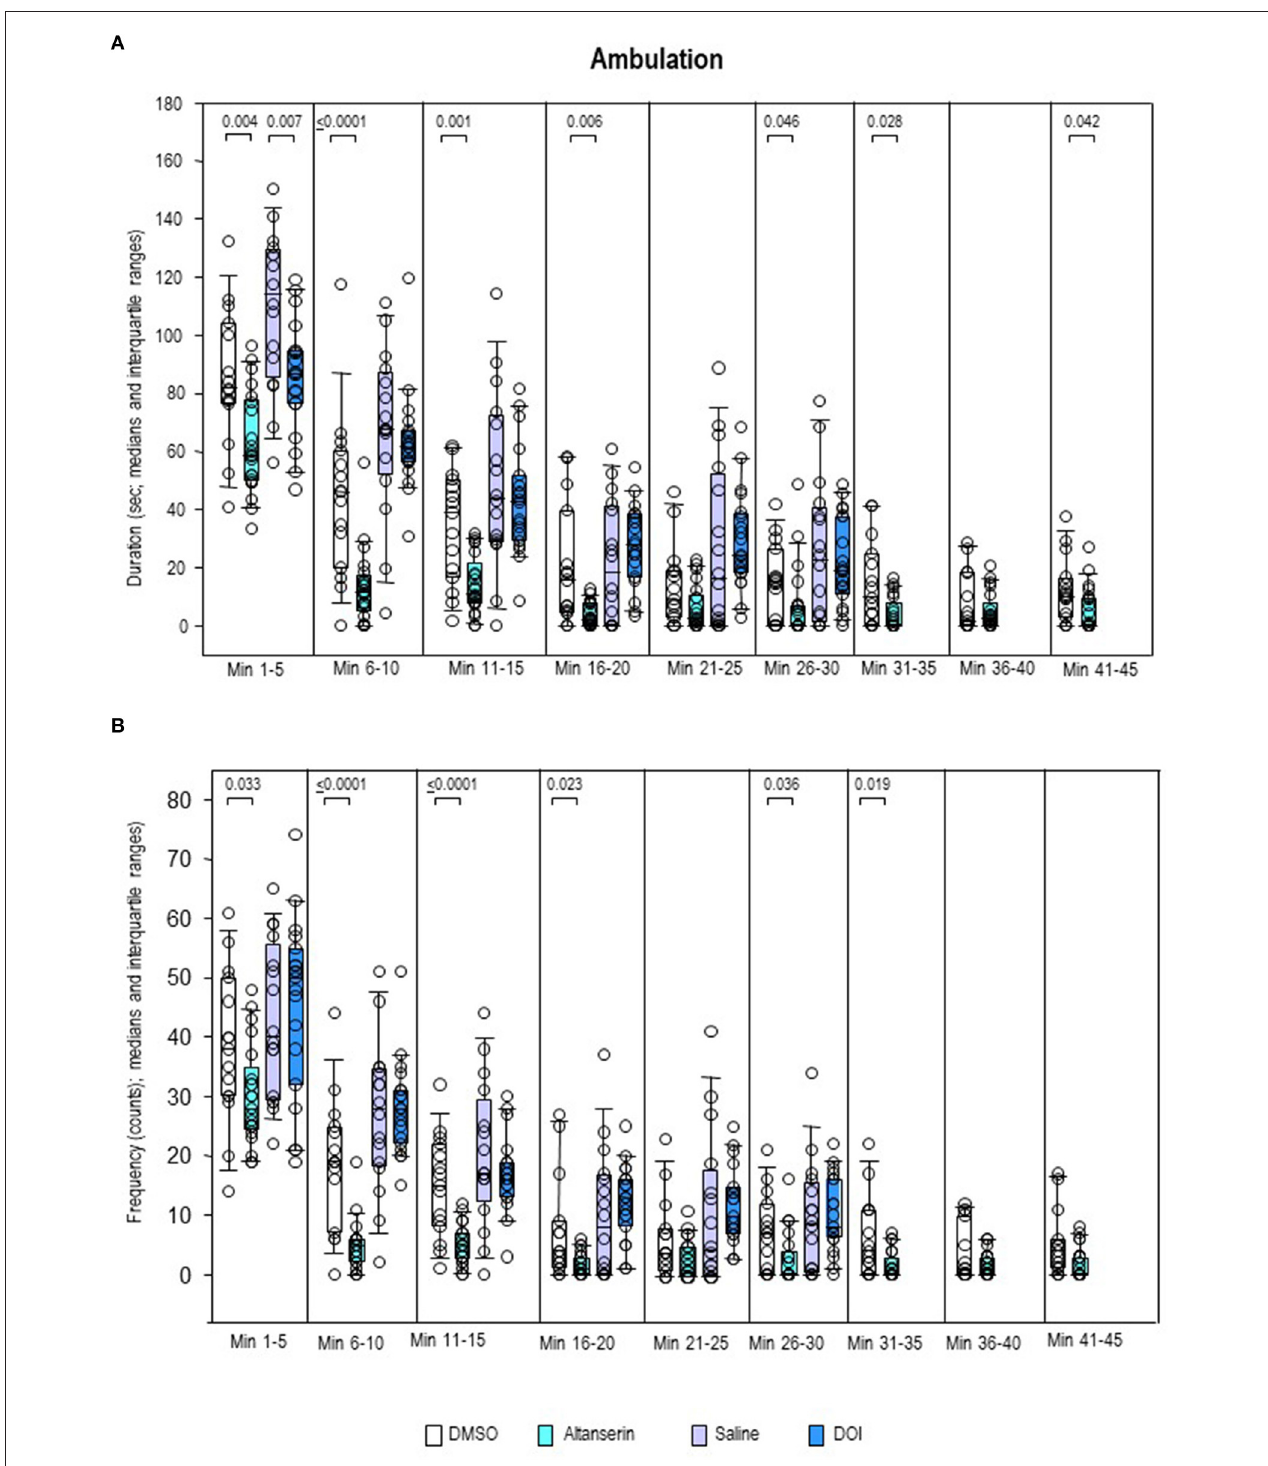
FIGURE 7 | Ambulation. Duration (s) and frequency (counts) after 10 mg/kg of altanserin (turquoise), 0.5 mg/kg of 2,5-dimethoxy-4-iodoamphetamine (DOI; blue), and the respective vehicles [dimethyl sulfoxide (DMSO), white; saline, light purple]. The figure shows box and whisker plots of median ambulation durations (A) and frequencies (B) in the individual 5-min bins. The 25th/75th percentiles are given in the boxes, while the 5th/95th percentiles are represented by the whiskers. The circles represent the individual animals. Groups (altanserin vs. DMSO; DOI vs. saline) were compared with the independent Mann–Whitney U -test (two-tailed, α = 0.05). Significant p -values are